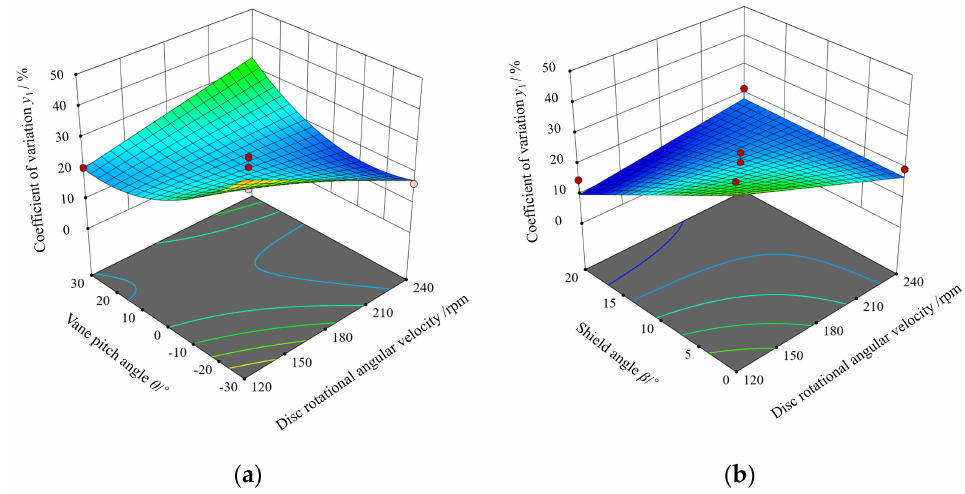
Figure 14. The effect of interaction factors on coefficient of variation. ( a ) y 1 = f (25 ◦ , B , C , 10 ◦ ); ( b ) y 1 = f (25 ◦ , B , 0 ◦ , D ).